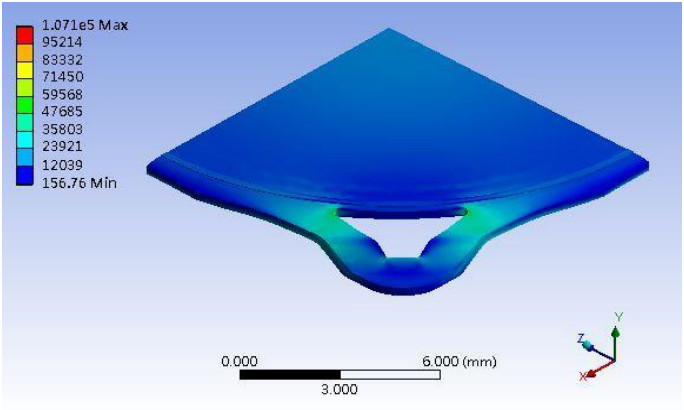
Figure 19. ANSYS simulation result.